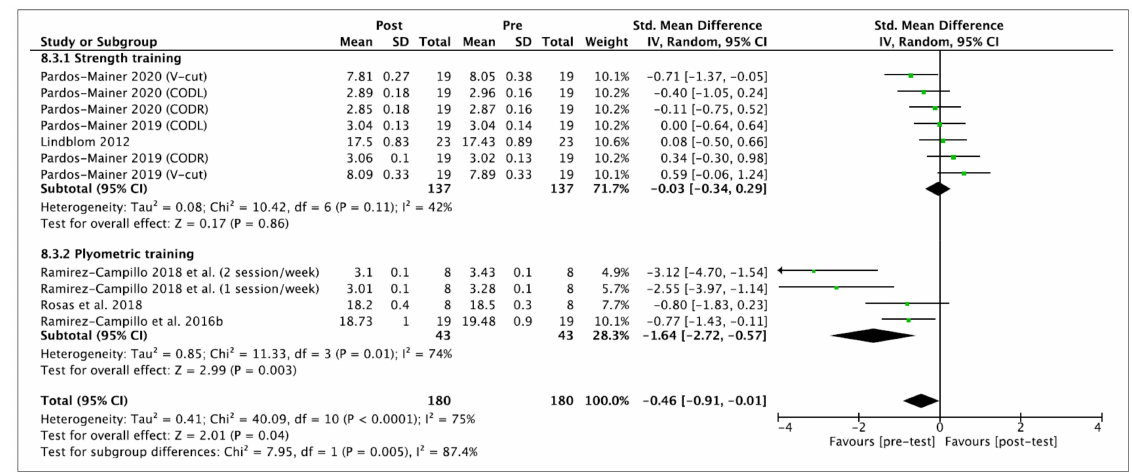
Figure 7. Forest plot of within-mode effect sizes with 95% confidence intervals (CIs) in the time of change of direction (s). IV: inverse variance method; SD: standard deviation; Std: